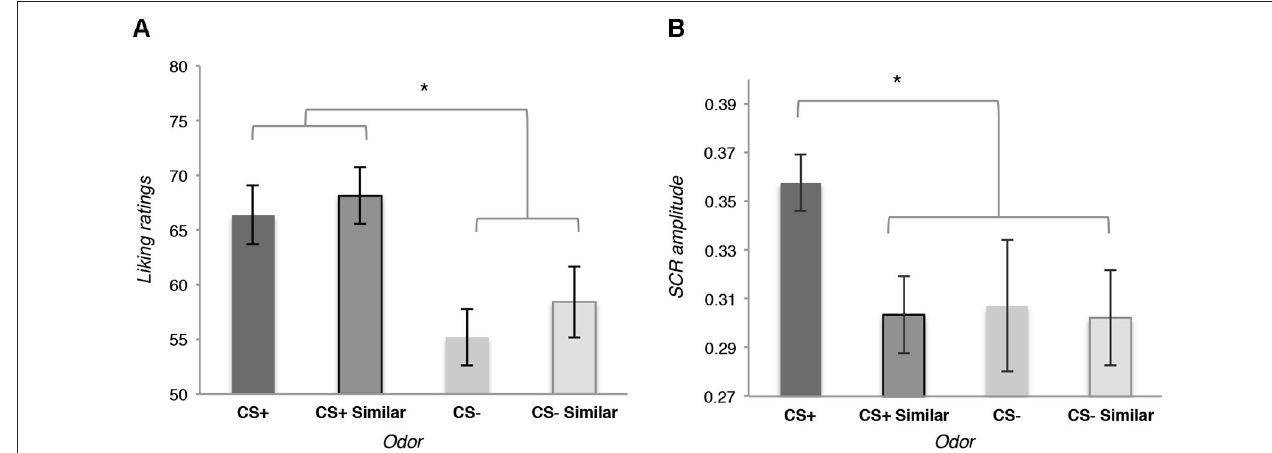
perception of the four odors used as CS at the end of the Pavlovian conditioning during the rating phase. Error bars ( ± 1 SEM ) are adapted for within design (Cousineau, 2005).